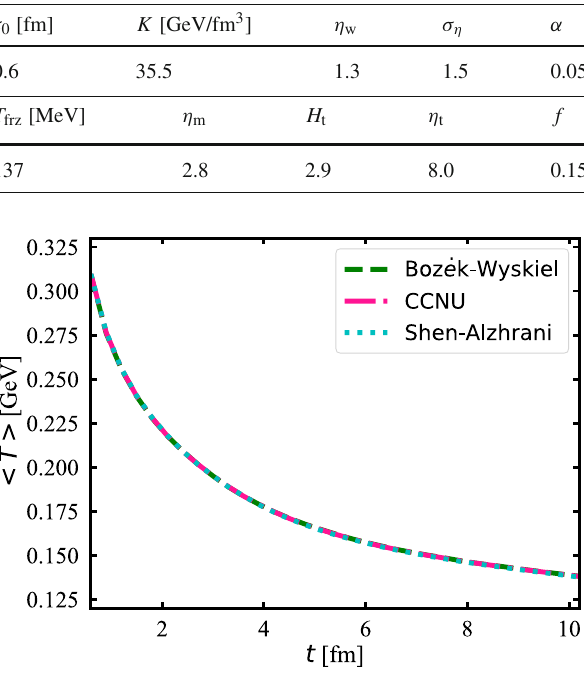
and (cid:19) is the bulk pressure (taken as zero in our current cal- culations); g μν = diag ( 1 , − 1 , − 1 , − 1 ) is the metric tensor and (cid:9) μν = g μν − u μ u ν is the projection tensor. These